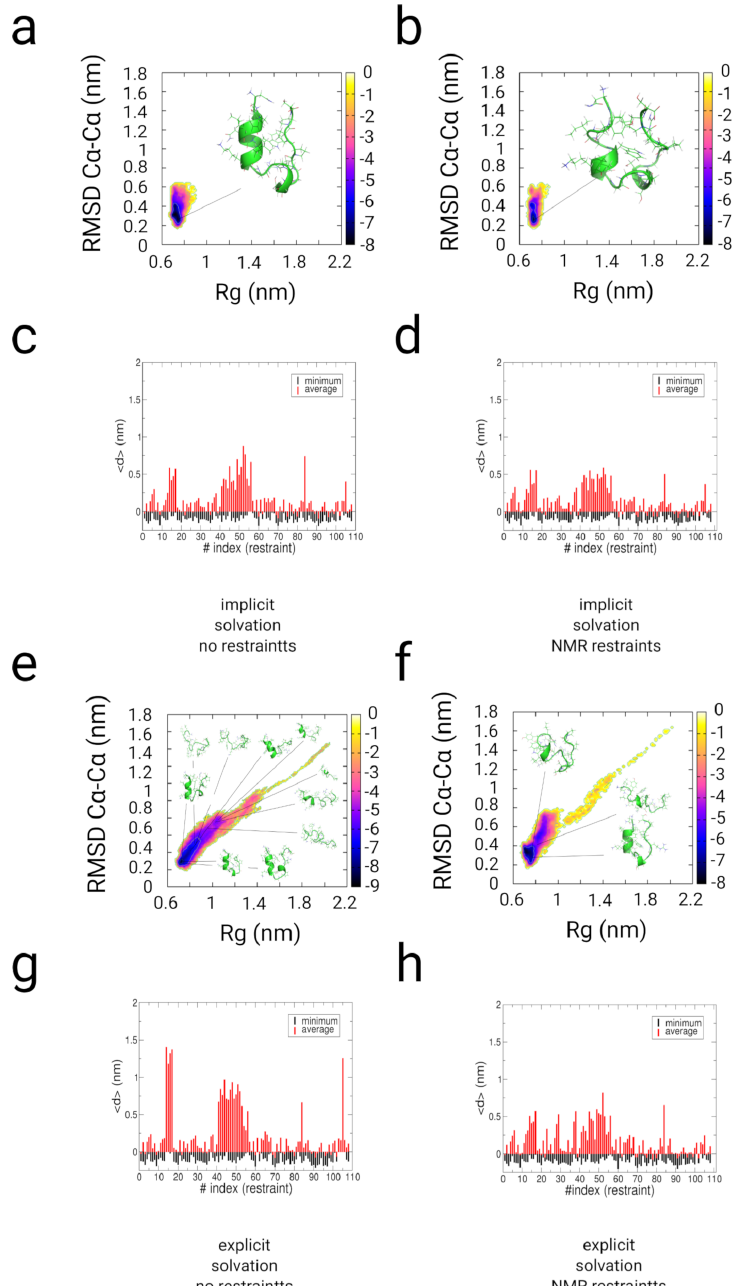
Figure 4. Results from enhanced sampling simulations along multiple pathways with and without restraints from NMR-NOESY experiments on TrpCage. We started the simulation from an extended conformation [93] in implicit ( a – d ) and explicit solvent ( e – h ). ( a , c , e , g ) Results from path-sampling simulations without restraints in implicit and explicit solvent (using the multiple path sampling methodology without experimental restraints). ( b , d , f , h ) Results from restrained simulations using the experimental NMR restraints for TrpCage. ( a , b , e , f ) Free energy landscapes as function of RMSD C α − C α and radius of gyration (Rg). ( c , d , g , h ) Minimal and average value of the difference of the distance between restraint indexed atoms and the experimental value. The populations in the free energy landscapes of TrpCage are shifted in the restrained simulations with a significantly lower propensity of the unfolded ensemble at RMSD C α − C α greater than 0.4 nm. The presence of the explicit solvent stabilizes near native configurations and leads to a better convergence of the simulation to the set of experimental restraints. Energy values on the color bars are in k B T